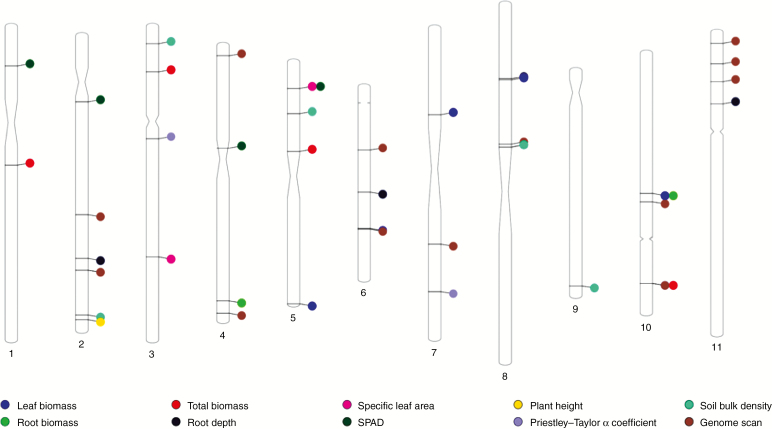
Chromosomal ideogram of common bean. Significant markers in the genome association analysis of phenotypic and ecological traits and the genome scan are shown.